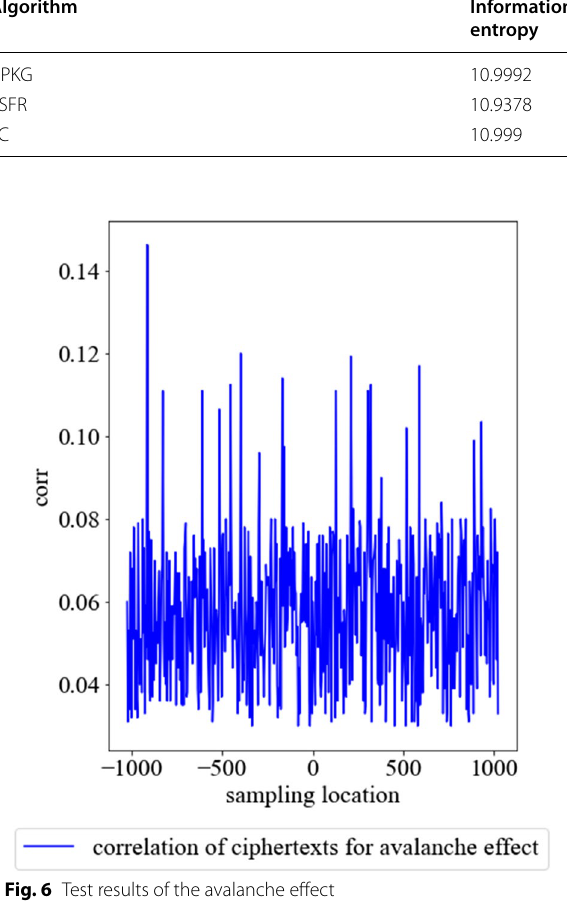
Fig. 6 Test results of the avalanche effect